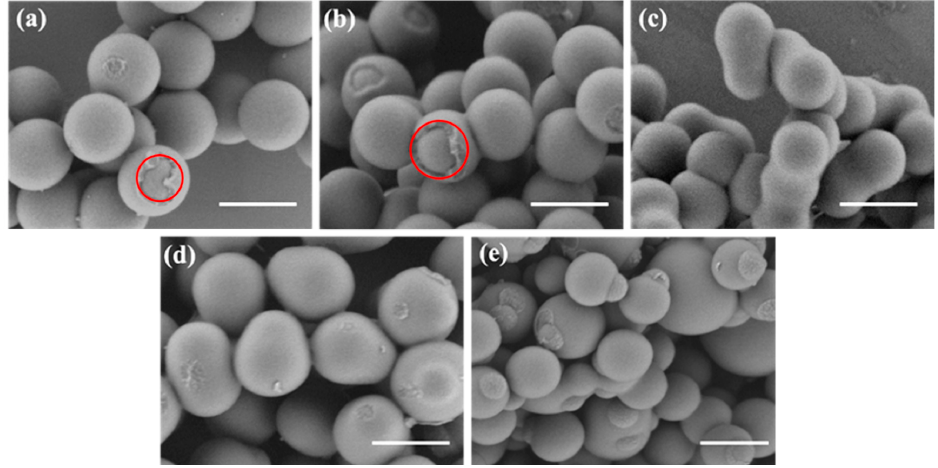
Figure 3. SEM images of SiO 2 @MPSQ particles prepared using different ratios of SiO 2 particles and 3-mercaptopropyltrimethoxysilane (MPTMS): ( a ) 1:0.528, ( b )1:1.060, ( c ) 1:1.580, ( d ) 1:1.820, and ( e ) 1:2.110 (m/m). Scale bar: 500 nm.